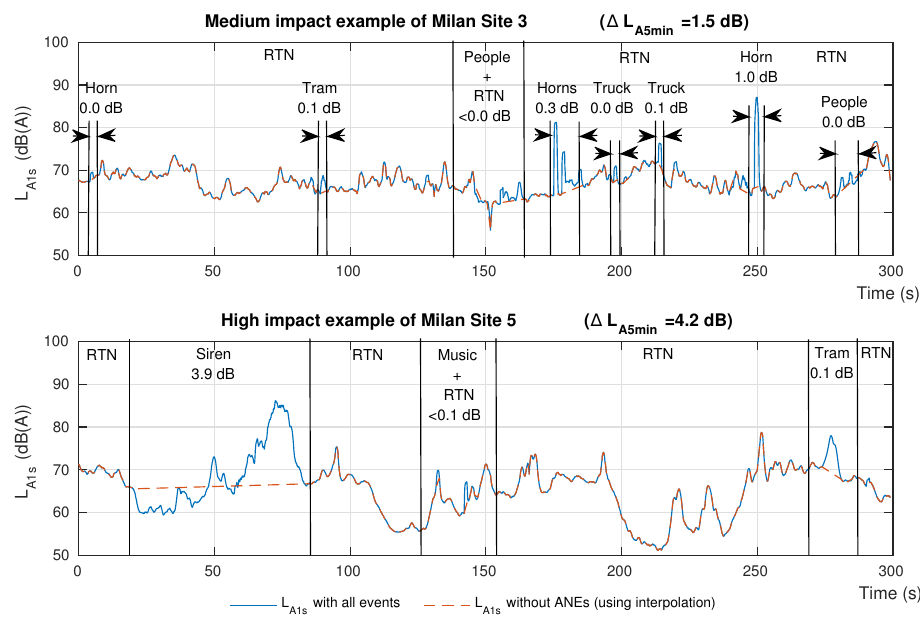
Figure 7. Joint impact of all the existing ANEs in the L A 5 min measurement for two different recording locations in the urban environment.